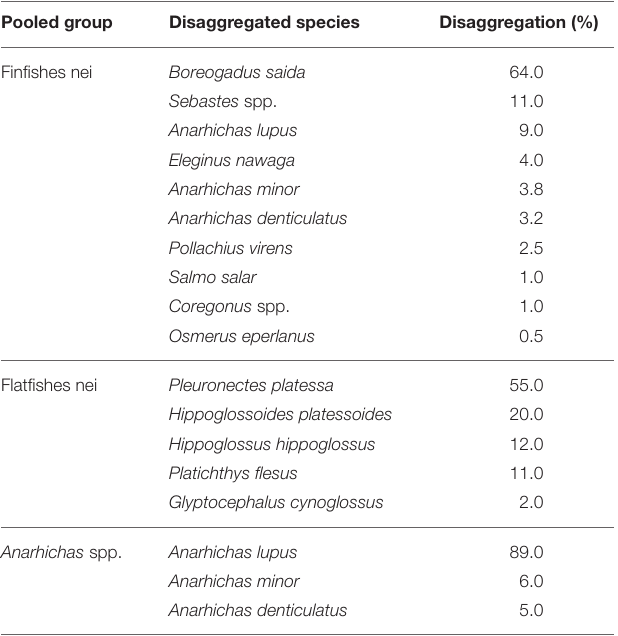
TABLE 1 | Taxonomic disaggregation of highly uninformative pooled taxonomic groups (“nei” = not elsewhere included) in the reported catch data for Russia and the former USSR.